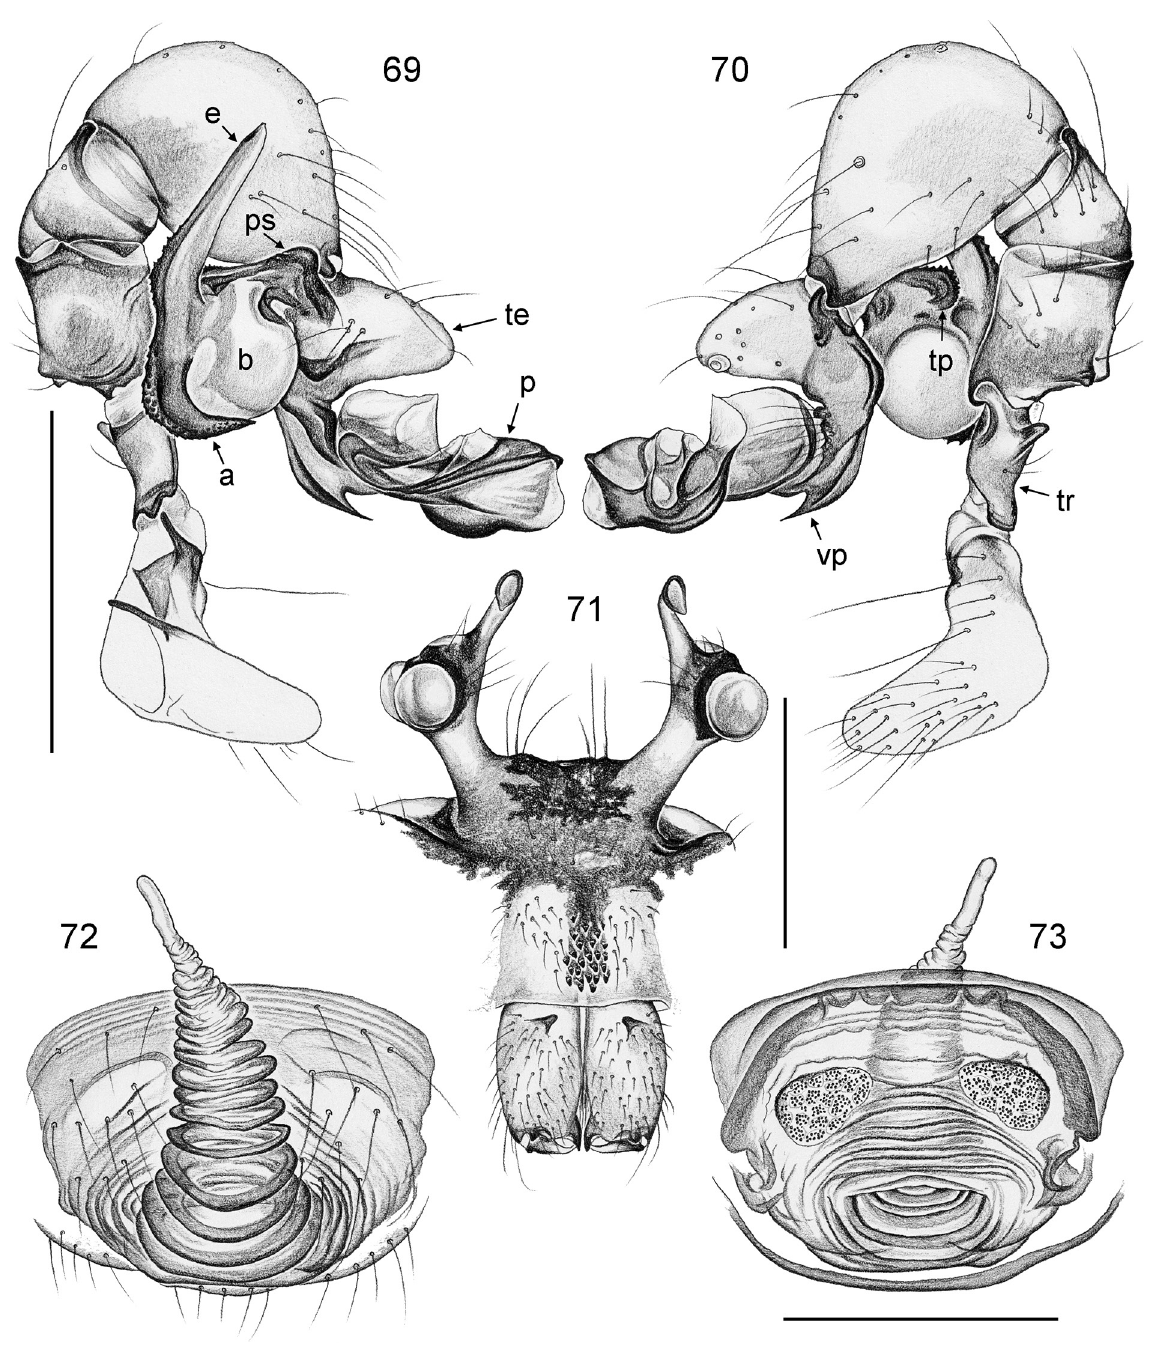
Figs 69–73. Panjange isarog Huber sp. nov. (ZFMK, Ar 13013, 13014). 69–70 . Left male palp, prolateral and retrolateral views. 71 . Male prosoma and chelicerae, frontal view. 72–73 . Cleared female genitalia, ventral and dorsal views. Abbreviations: a = appendix; b = genital bulb; e = embolus; p = procursus; ps = proximal bulbal sclerite; te = tarsal elongation; tp = toothed process of proximal bulbal sclerite; tr = trochanter. Scale bars: 69–71 = 0.5 mm; 72–73 = 0.3